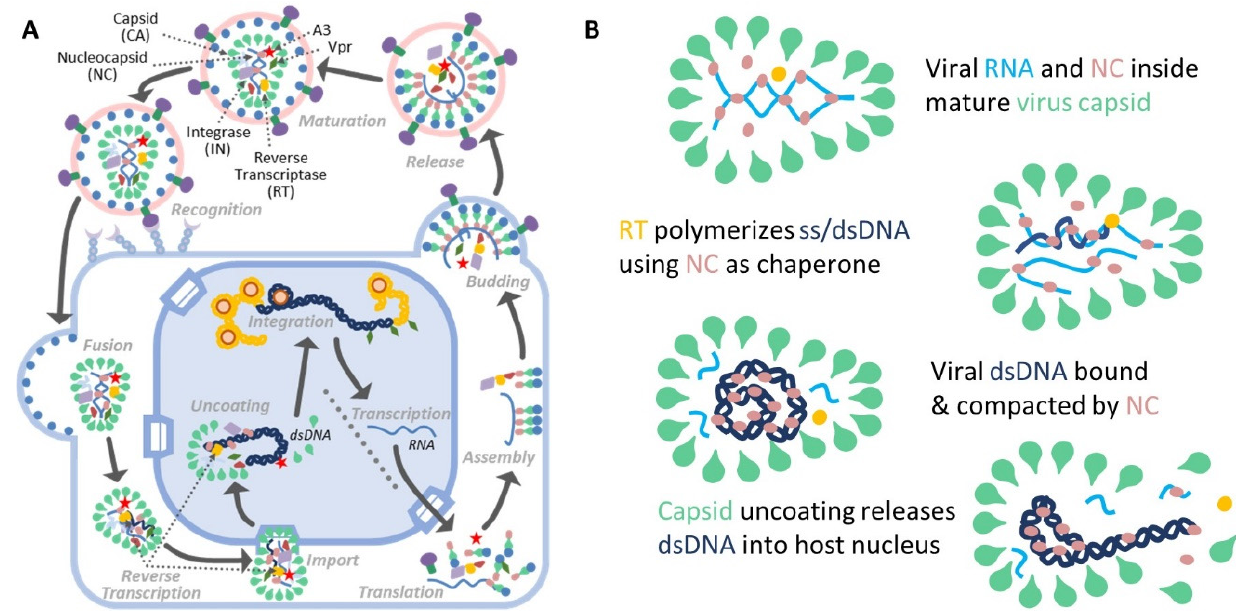
Figure 1. Overview of the role of NC in HIV replication. ( A ) NC is critical to multiple steps of the full lifecycle of HIV. As a subdomain of the Gag protein, NC is critical for packaging vRNA in the viral particle. When the viral particle matures, NC is cleaved from Gag and is contained inside the capsid with the vRNA. NC acts as a chaperone for reverse transcription of the viral RNA into DNA and binds and aggregates nucleic acids with high affinity. ( B ) NC binds and condenses viral DNA during the reverse transcription. NC acts as a chaperone during the synthesis of ( − )DNA using vRNA as a template followed by synthesis of the complementary (+)DNA. For the full ~10 kbp viral DNA to be contained inside the capsid, which has a diameter comparable in length to the natural persistence length of DNA, the DNA must be compacted to a volume much smaller than predicted by the natural thermodynamic fluctuations of uncondensed DNA. Once the capsid uncoats, the viral DNA and viral proteins will be released into the host cell nucleus, enabling integration.